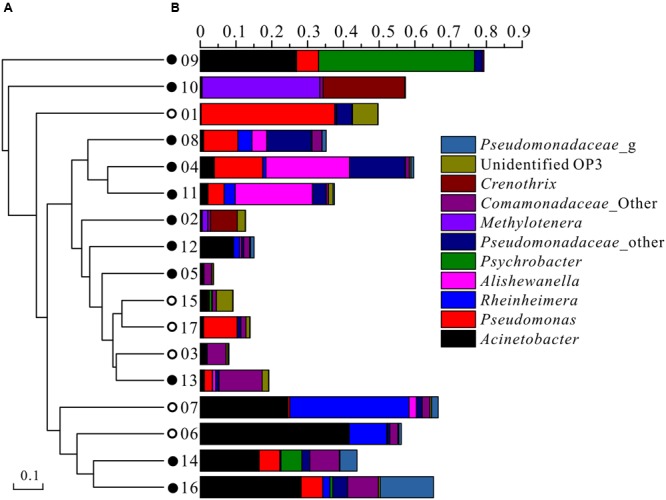
Microbial community compositions of groundwater samples along the drainage channels. Solid circles represented high As samples while open circles represented low As samples. (A) UPGMA cluster tree based on chord distance using genus data; (B) microbial compositions at the genus or family level. The legend showed the top 11 OTUs (at the 97% level).